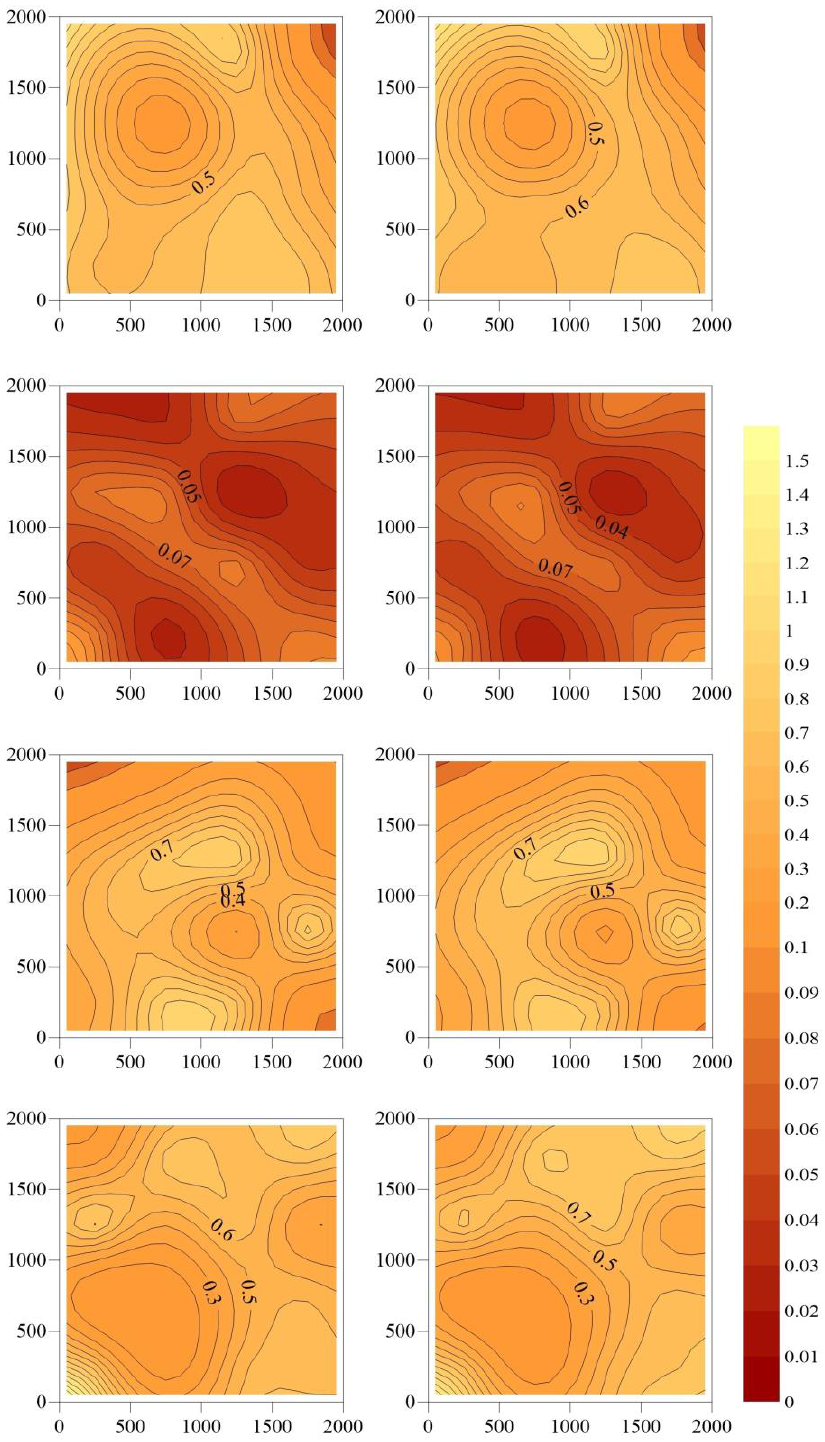
( ) | | 𝜀 ∈ 0.0075; 0.01 (on the right), per- 𝑖